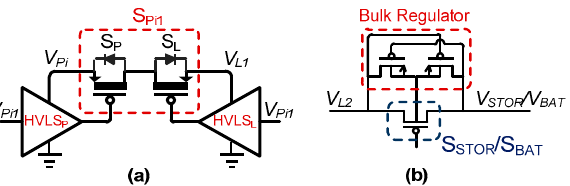
Figure 7. ( a ) Bi-directional switch(s) between PZTs and Inductor (S Pi1 , S Ni1 ). ( b ) Bulk Regulator for S STOR and S BAT .